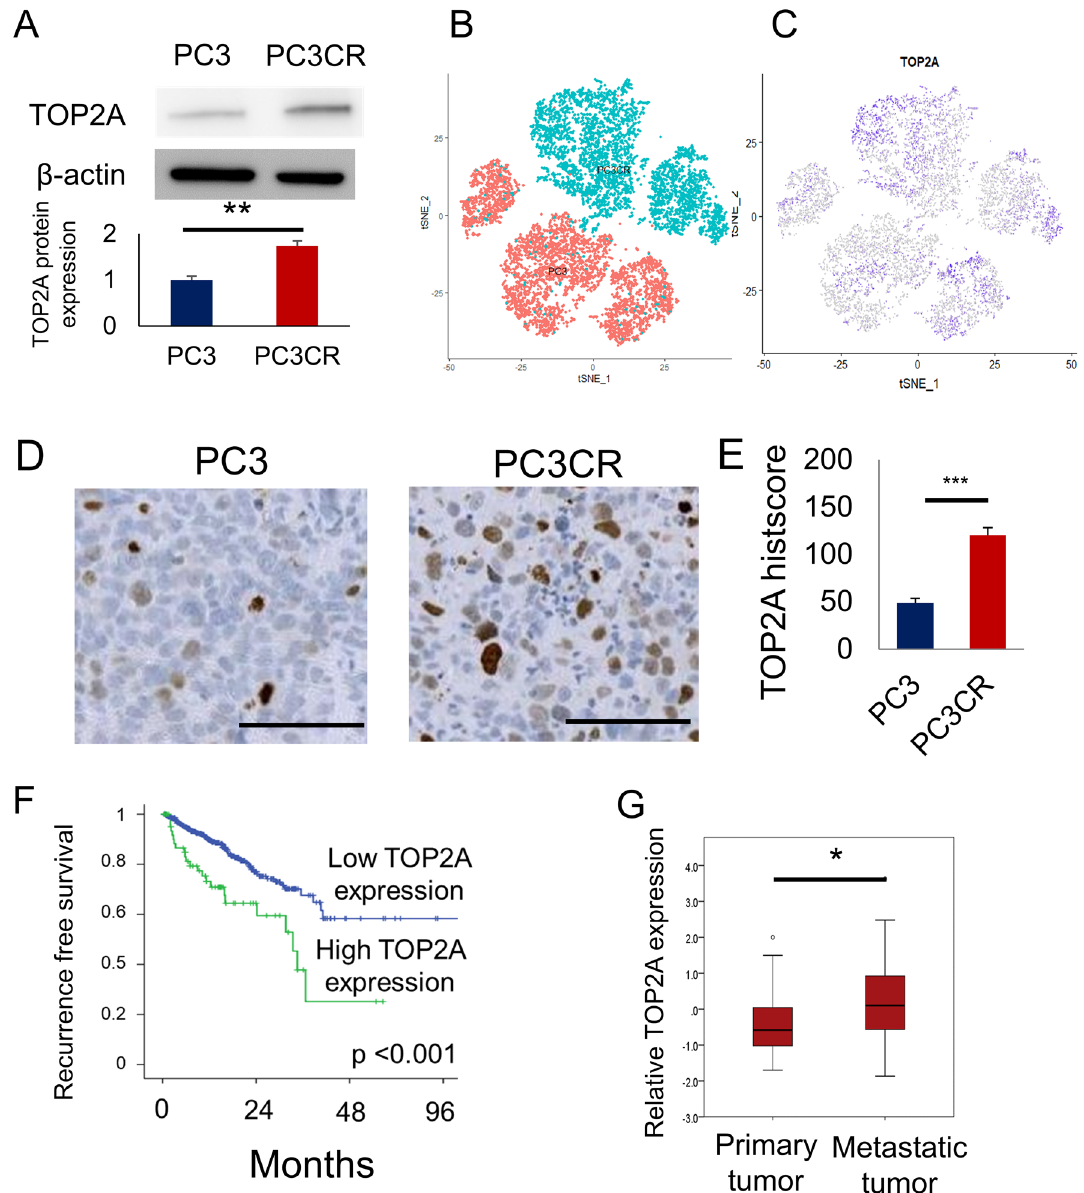
Figure 2. Significance of topoisomerase II alpha (TOP2A) expression. ( A ) TOP2A protein expression in PC3 and PC3CR cells. ( B ) PC3 and PC3CR cells were clustered via single-cell RNA-seq. Red dots indicate PC3 cells, and blue dots indicate PC3CR cells. ( C ) TOP2A expression was visualized using a t-distributed stochastic neighbor embedding plot. More intense purple color indicates higher TOP2A expression. ( D ) Immunohistochemical staining for TOP2A in PC3 and PC3CR xenograft tumors. Bar indicates 100 µm. ( E ) The TOP2A immunohistochemistry score was significantly higher in PC3CR tumors than in PC3 tumors. ( F ) Kaplan–Meier curves of recurrence-free survival in The Cancer Gene Atlas prostate cancer cohort according to high or low TOP2A expression. ( G ) In the Fred Hutchinson cohort, metastatic prostate cancer had significantly higher TOP2A expression than localized prostate